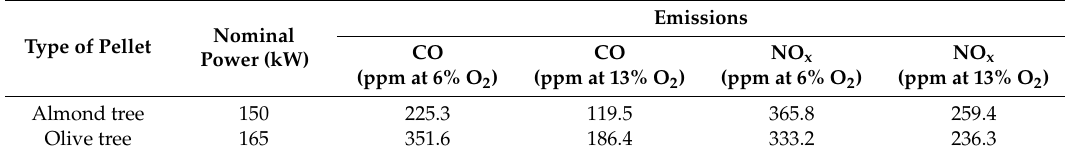
Table 3. Comparison of CO and NO x concentrations of exhaust gases for pellets from almond and olive trees during combustion in the BIO System